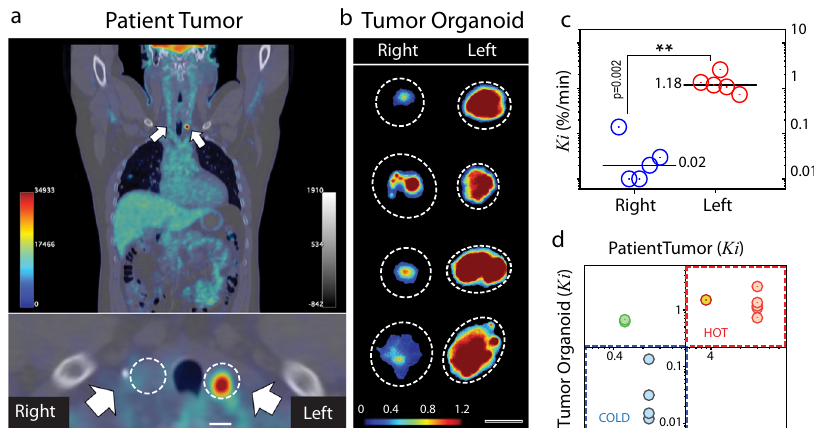
Fig. 4 Comparison of PET vs oPEM imaging. a PET/CT scan of patient T3. Two papillary thyroid carcinoma nodules (white arrows) show contrasting levels of FDG uptake. b oPEM images of tumor organoids derived from these nodules. The organoids retained the contrasting metabolic identity of the original two nodules. The dotted lines show the spatial extent of the individual organoids. The color bar shows radioactivity (Bq/pixel). Scale bar: 1 mm. c Scatter plot of FDG in fl ux constant ( K i ) for organoids ( n = 5) derived from left and right nodules. The median uptake is shown as a black line. The organoids derived from the left nodule took up >10 times more FDG on average than those from the right nodule. An unpaired two-tailed t test was applied for signi fi cance testing. d Scatter plot showing the correlation between the K i of organo i ds ( n = 13) and tumors of origin ( n = 4, shown i n four different colors; Pearson ’ s r = 0.756, P =